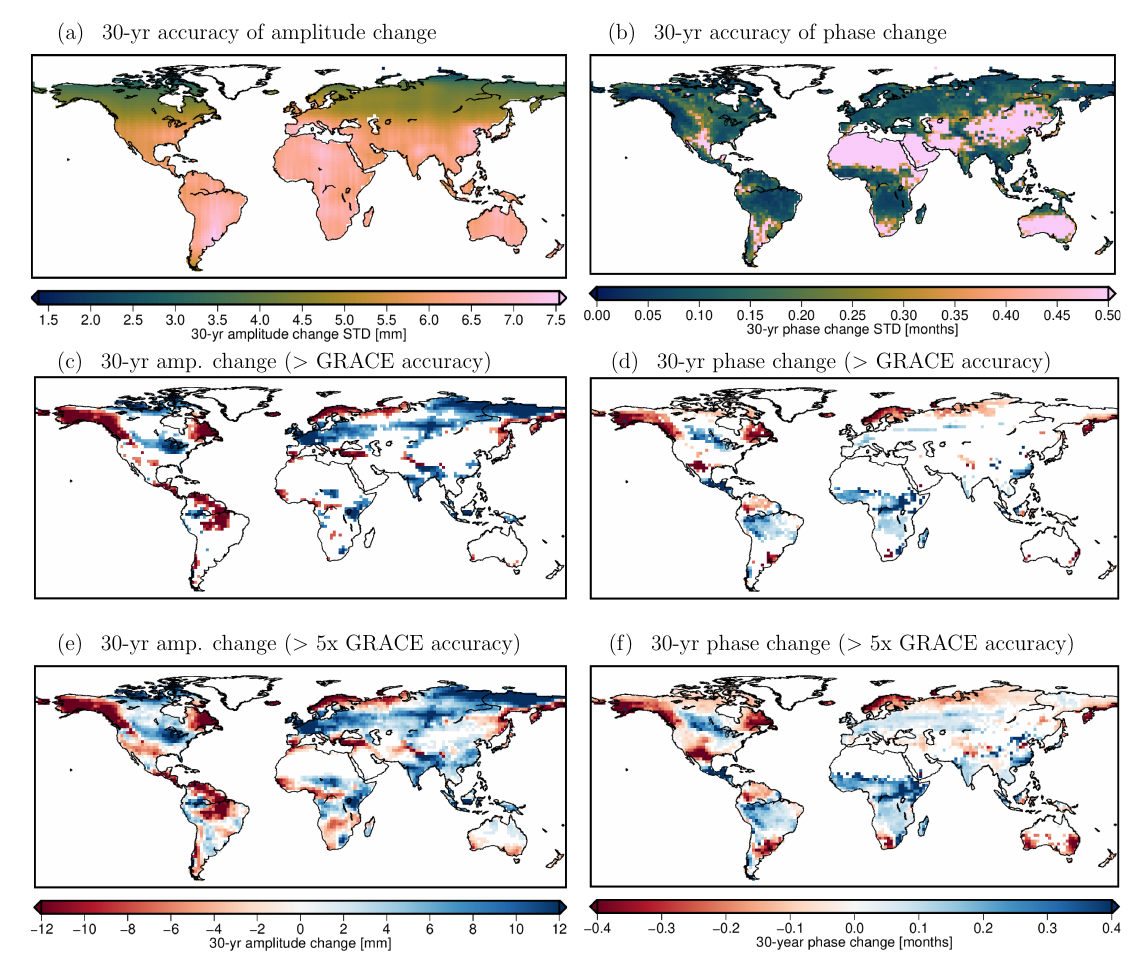
Figure 11. ( a ) standard deviation of GRACE TWS annual amplitude change over 30 years. ( b ) standard deviation of GRACE TWS phase change of annual cycle over 30 years. ( c ) MMMed mTWS annual amplitude change over 30 years that exceeds the GRACE accuracy (given in ( a )). ( d ) same as ( c ) but for phase change. ( e , f ) same as ( c , d ) but assuming the standard deviation of GRACE (given in ( a , b )) being five times